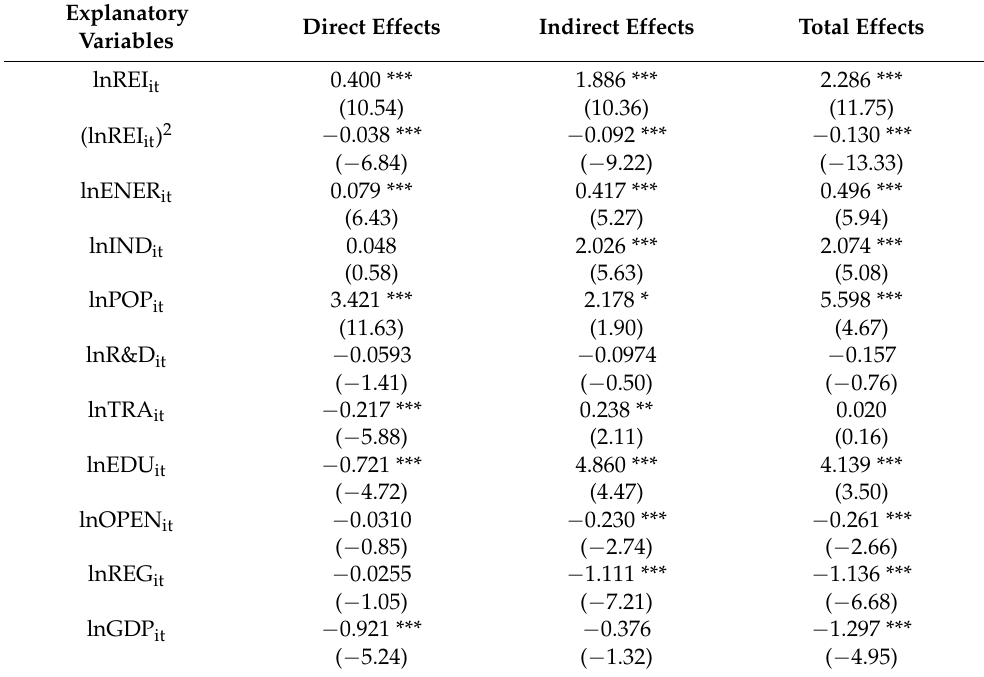
Table 4. Results of direct, indirect, and total effects under the